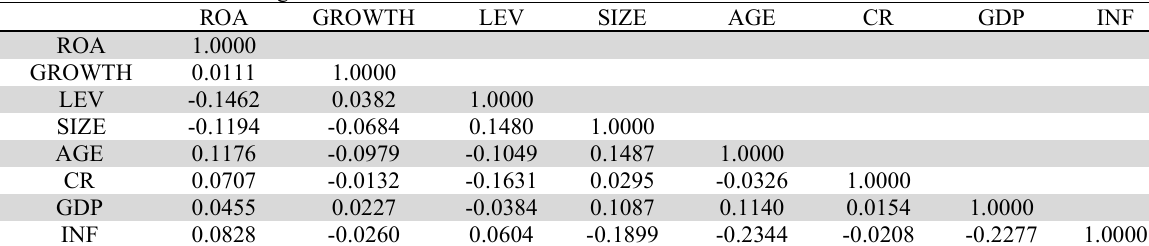
Correlation coefficients among